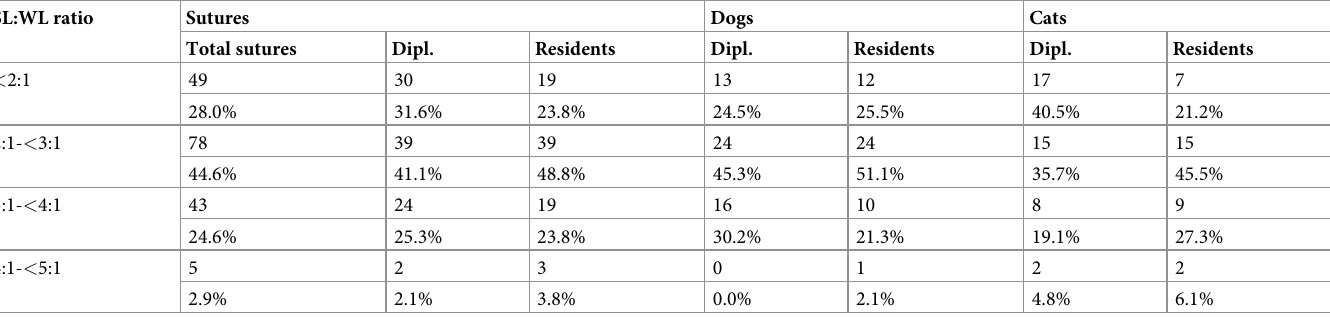
SL:WL ratio = suture length to wound length ratio, Dipl. = Diplomates.